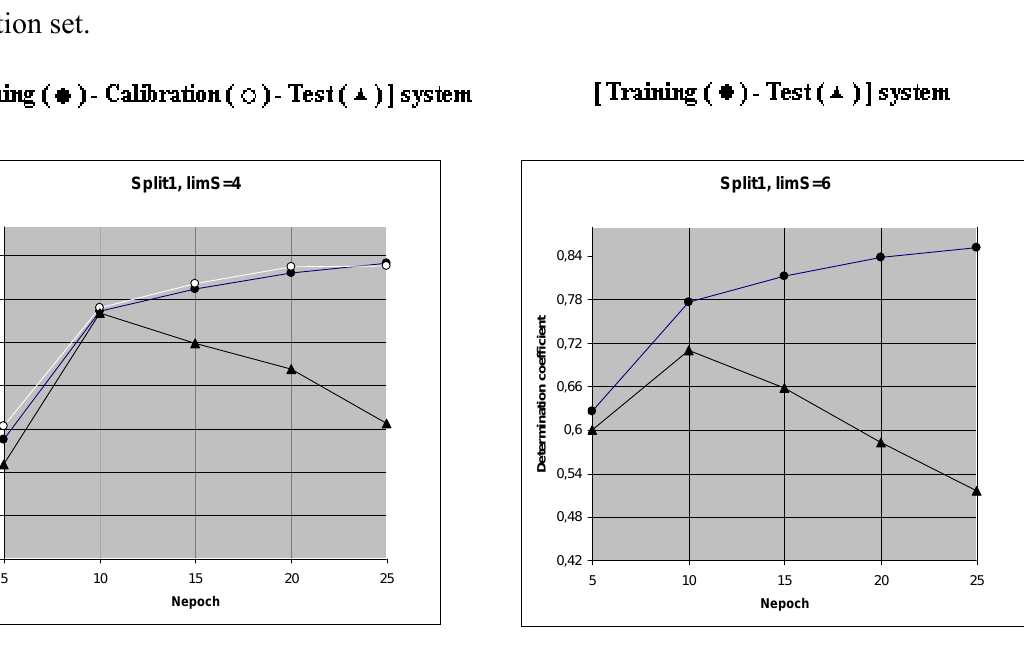
Figure 2. Results of computational experiments, which were used to establish of the preferable number of epochs of the Monte Carlo optimization (Nepoch). Triangles indicate curves for the test sets. Black circles denote the sub training set. White circles denote the calibration set.